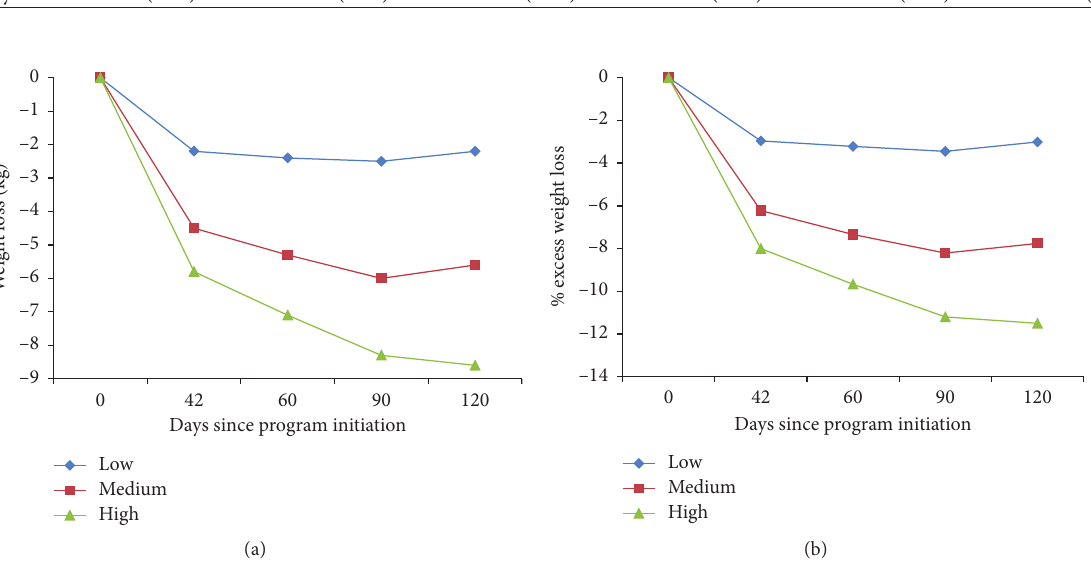
Figure 3: Weight loss results for application users by the frequency of application; tertiles of these frequencies were then made within the time period to create high (highest 1/3 of users), medium (middle 1/3 of users), and low (lowest 1/3 of users) frequency of use categories for comparison. Significant differences were found among all groups at all intervals shown ( P < 0 .